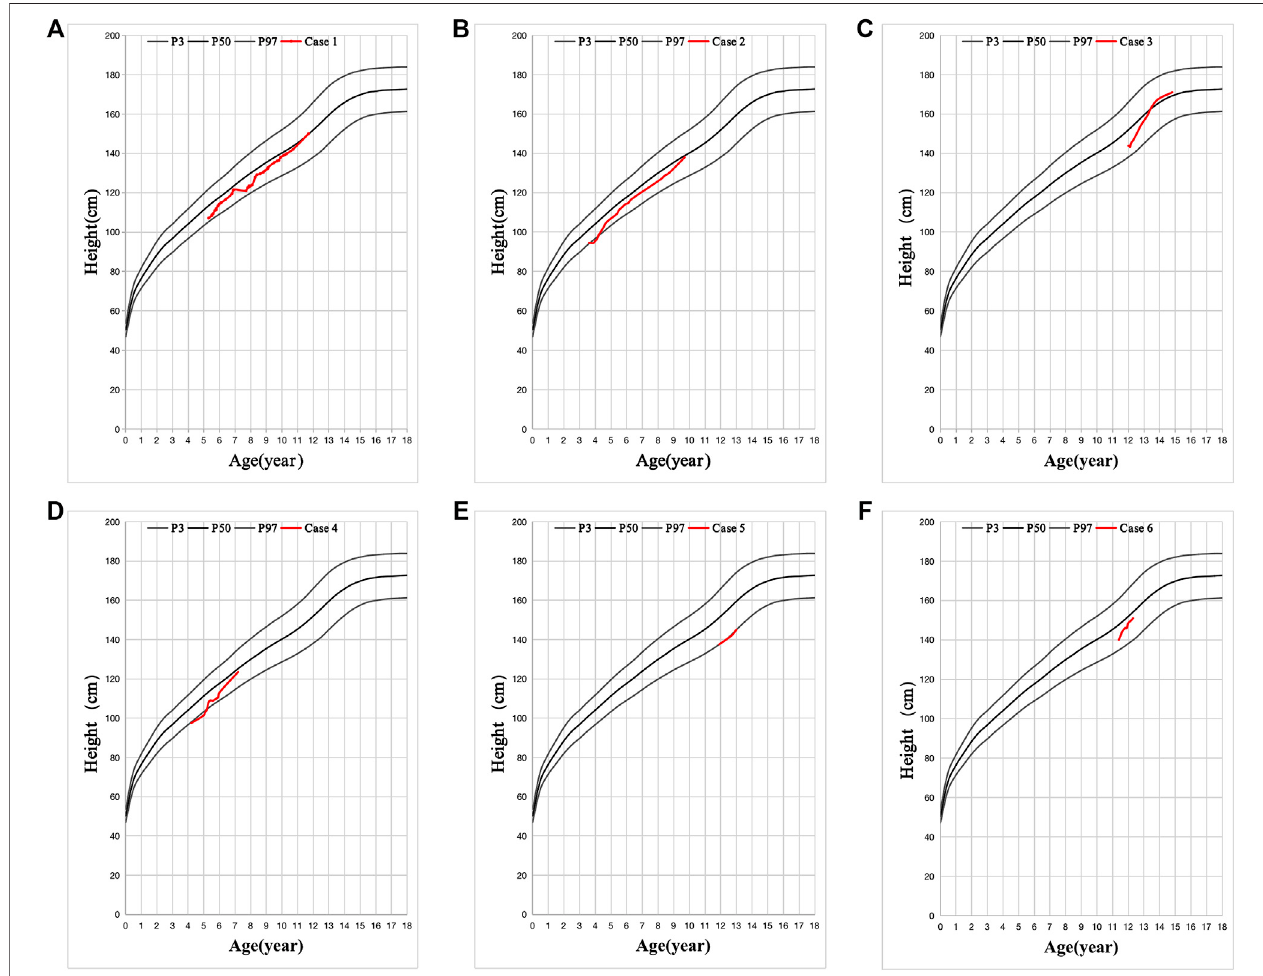
FIGURE 2 | Sixcases with favorable effect to recombinant human growth hormone (rhGH) treatment. (A-F) is the height changes in six cases. The black line is the standard height curve from top to bottom is 97, 50, and 3%, respectively. Height below the 3rd percentile is considered as Short Stature. The red line is the height changes of these 6 patients after VitD3 and rhGH